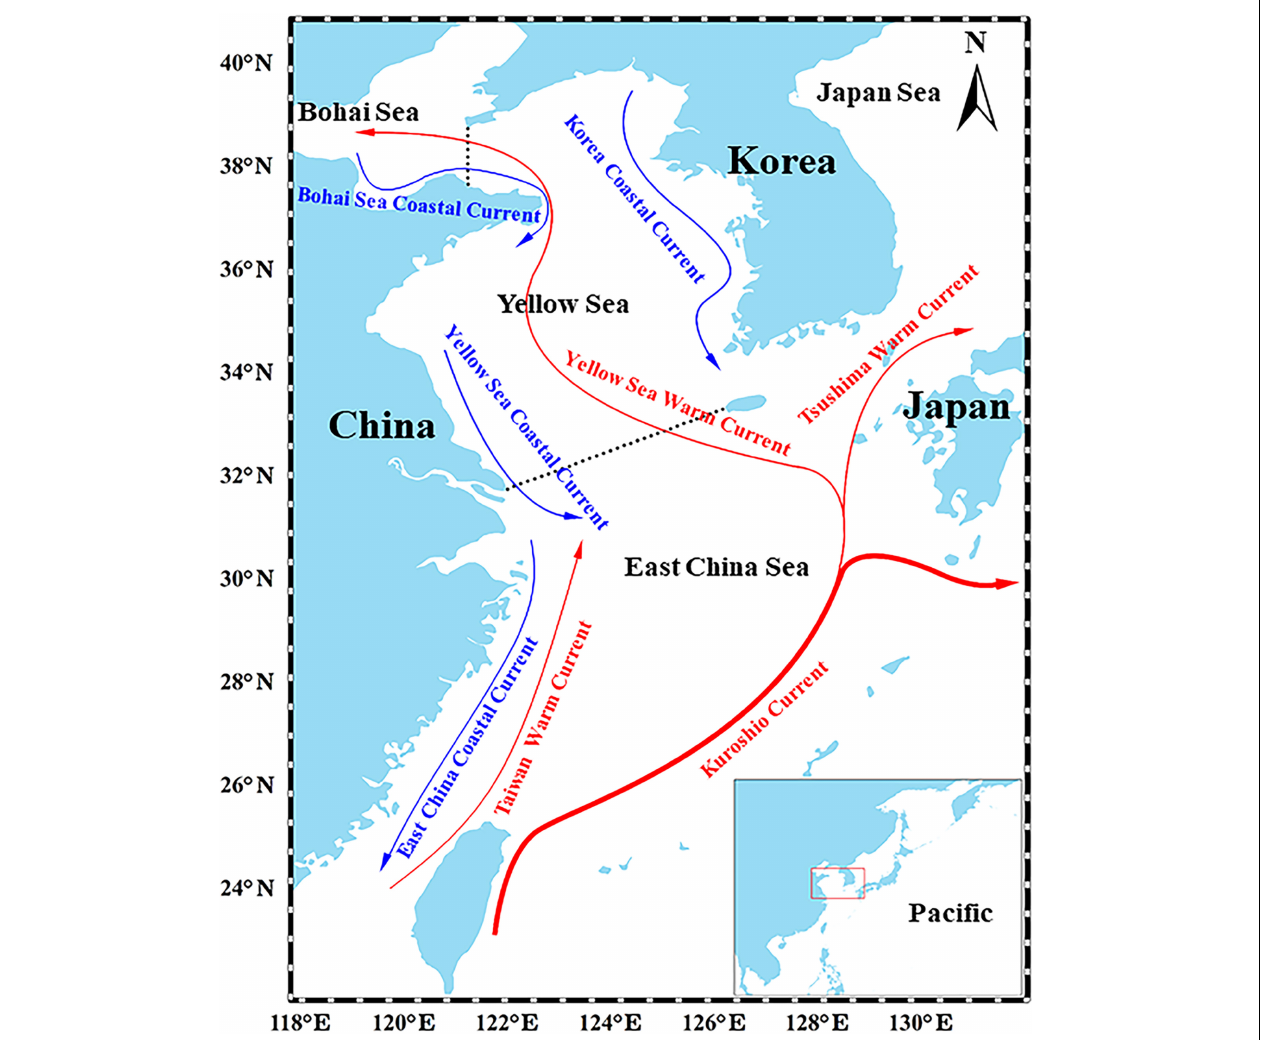
FIGURE 1 | Map of the East China Continental Shelf Sea. Red and blue lines represent the primary warm currents and cold currents that affect the YS, respectively. The panel at the bottom-right shows the location of the YS in the Northwest Pacific (Ma et al.,